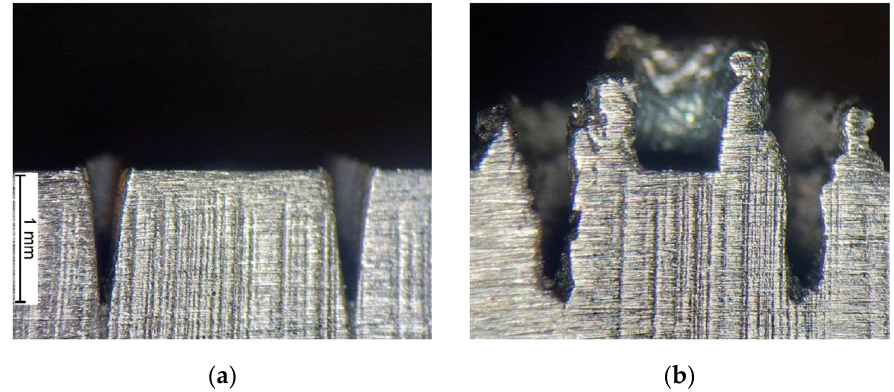
Figure 12. Comparison of transverse sections of annular grooves obtained ( a ) by the evaporation method and ( b ) by the method of the liquid phase.